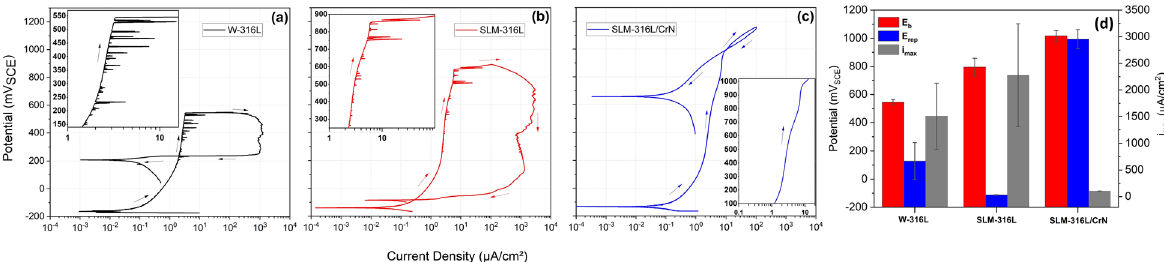
Fig. 5 Representative cyclic potentiodynamic polarization (CPP) curves. a W-316L, b SLM-316L, and c SLM-316L/CrN tested in 3.5 wt% NaCl. The inserted graphs depict the metastable pitting of the individual specimen.